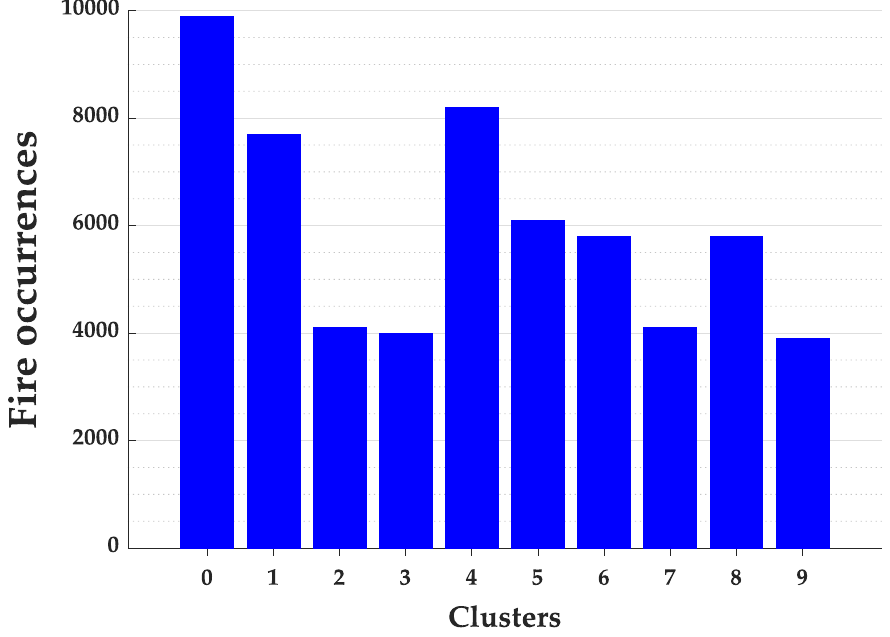
Figure 9. Fire occurrences for each cluster of the Pará